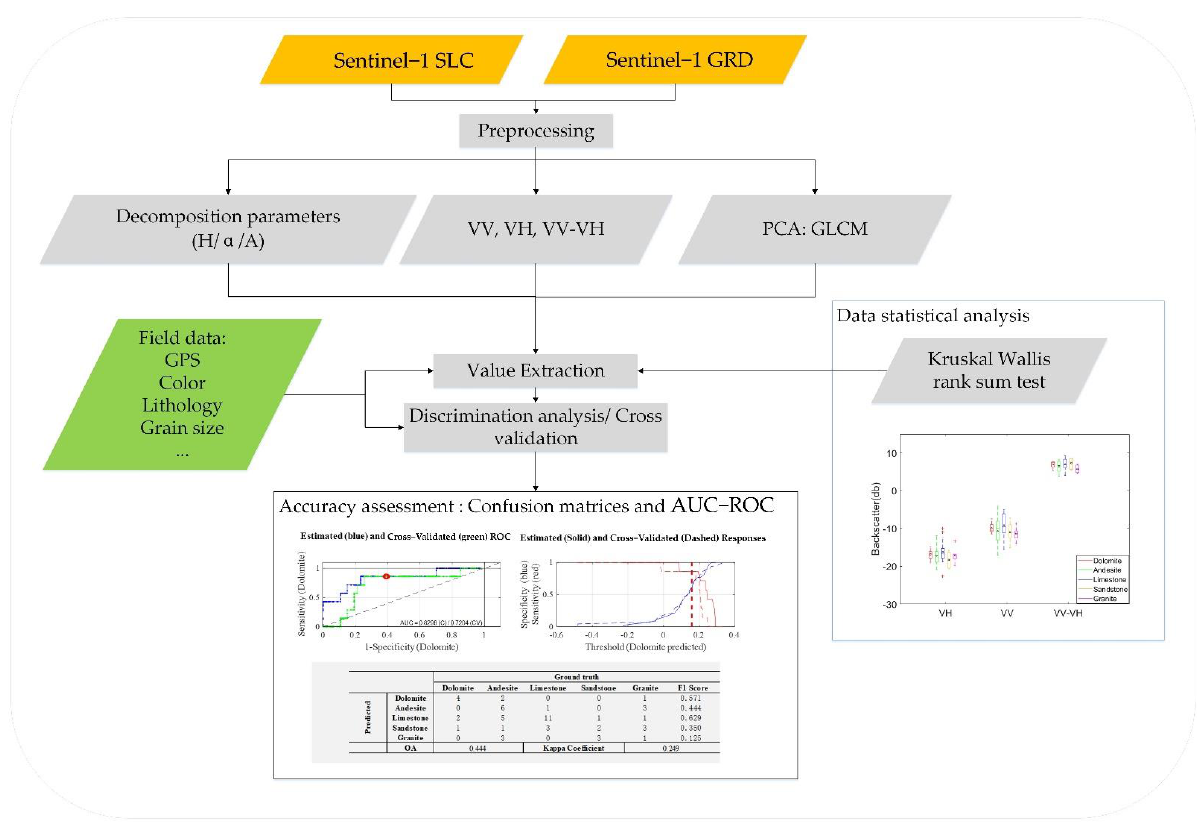
Figure 2. Methodological flowchart of this study. The clear and big images and table in the data statistical analysis part and Accuracy assessment part can be found in the Result section.